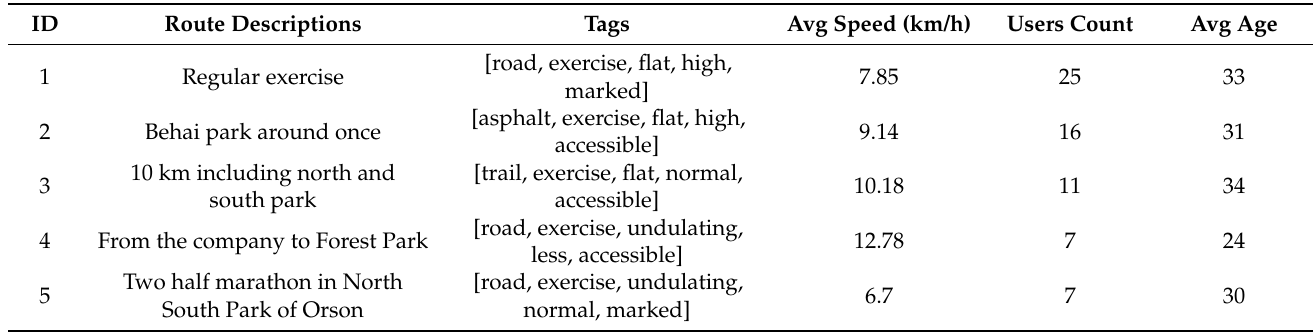
Table 1. The sample data of Adidas